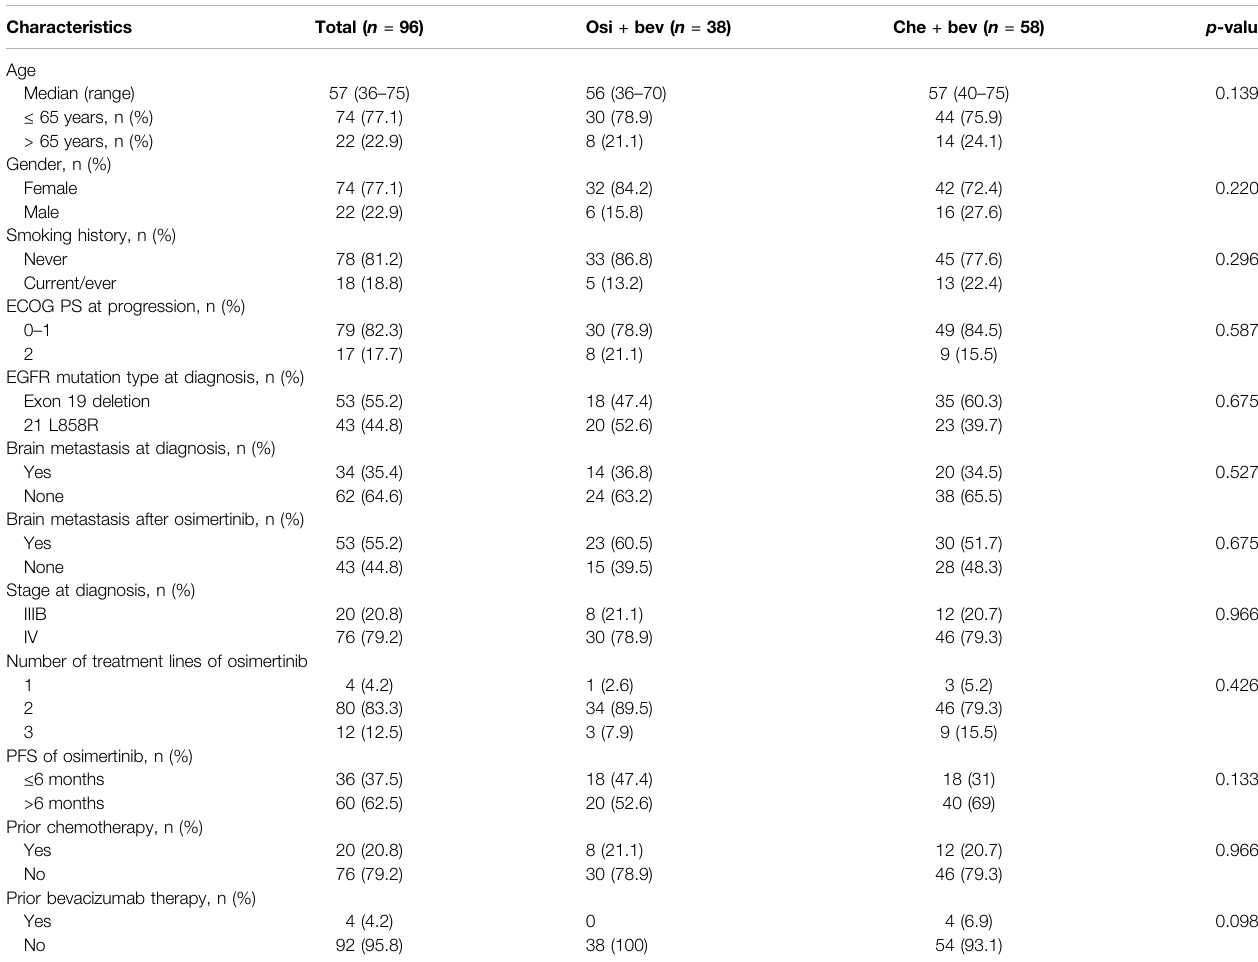
TABLE 1 | Baseline characteristics of patients.